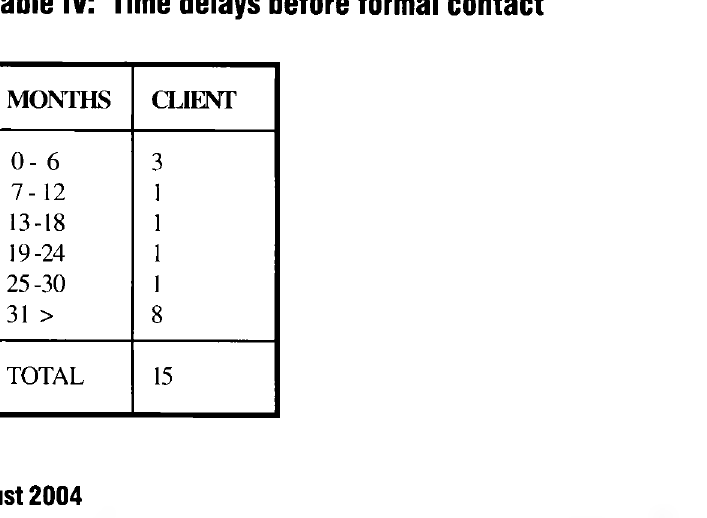
Table IV: Time delays before formal